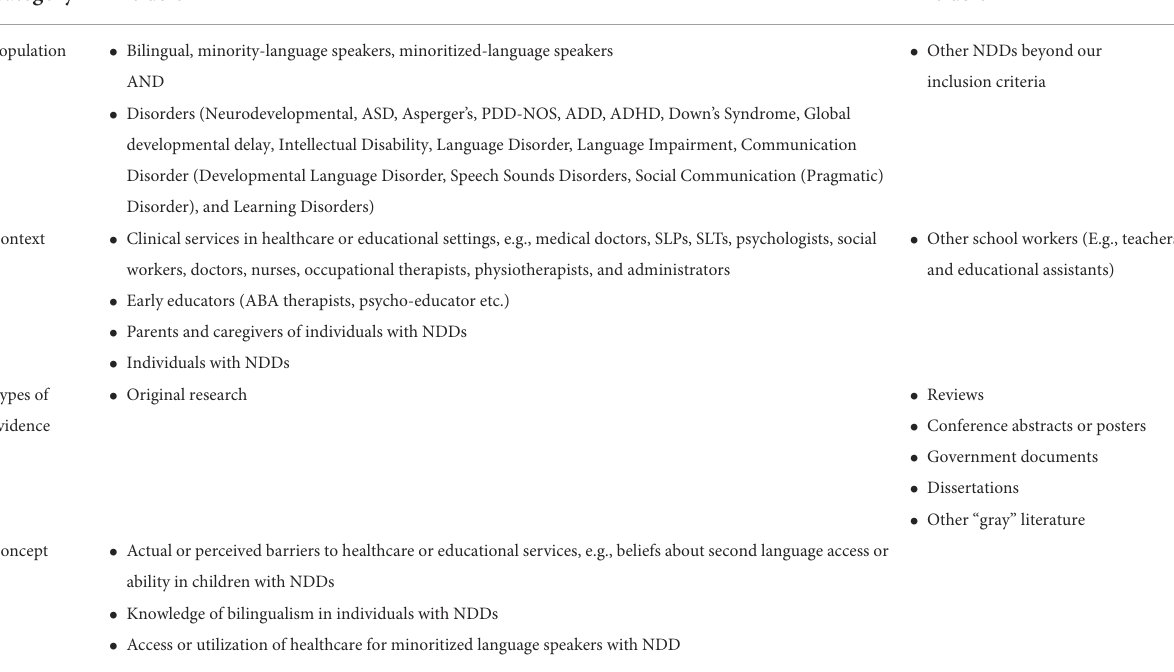
TABLE 1 Inclusion and exclusion criteria for